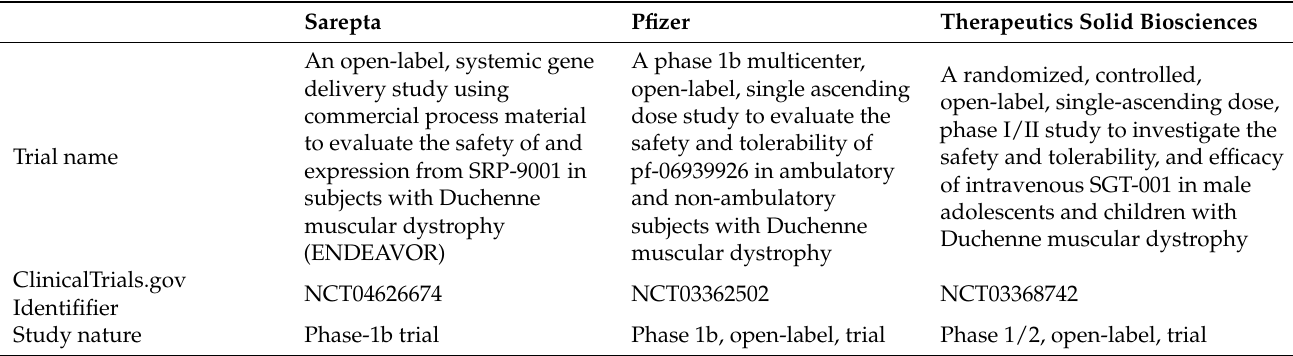
Table 1. Current status of systemic AAV mini/micro-dystrophin clinical